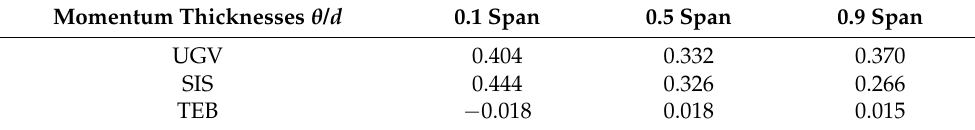
Figure 10. The velocity distributions of the guide vane’s wake at ( a ) 0.1 span, ( b ) 0.5 span, and ( c ) 0.9 span. Table 5. The non-dimensionalized momentum thickness θ / d distribution in different radial